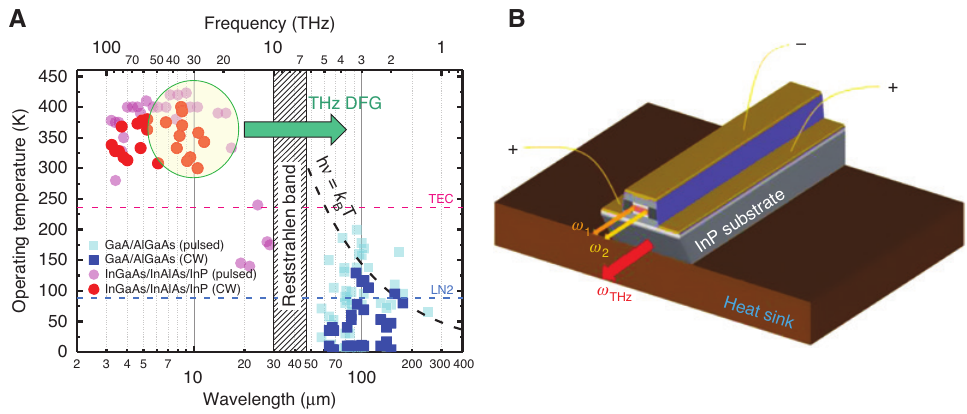
Figure 1: Current status of maximum operating temperature of QCLs and THz DFG-QCL schematic. (A) Operating temperature of QCLs as a function of the emission wavelength (or frequency, top axis). THz DFG can be achieved in